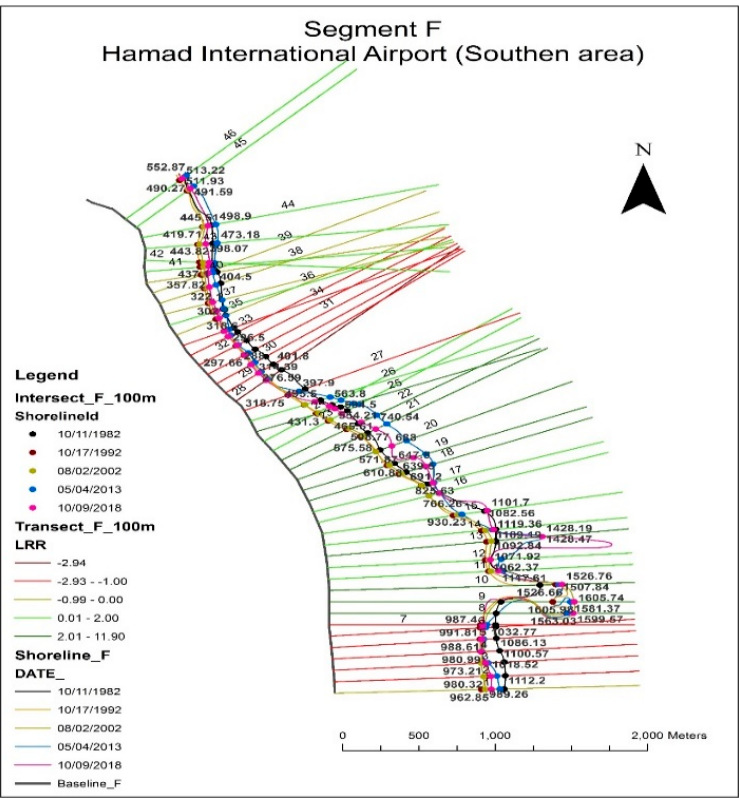
Figure 20. Southern part of Hamad International Airport.